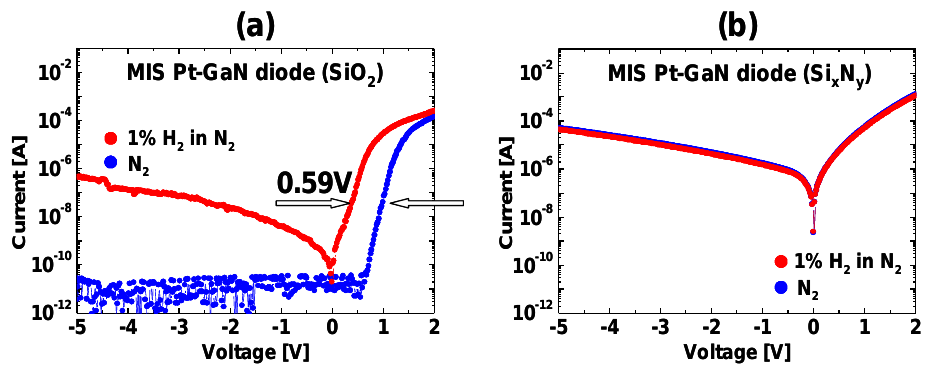
Figure 5. I–V characteristics of MIS Pt–GaN diodes with both 10 nm SiO Si N dielectrics (b) in N x y Reproduced with permission from Reference [17]. Copyright The Japan Society of Applied